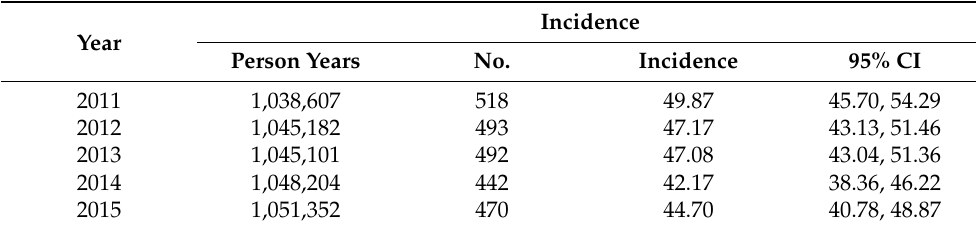
Table 2. Annual incidence of orbital wall fractures in the general Korean population from 2011 to